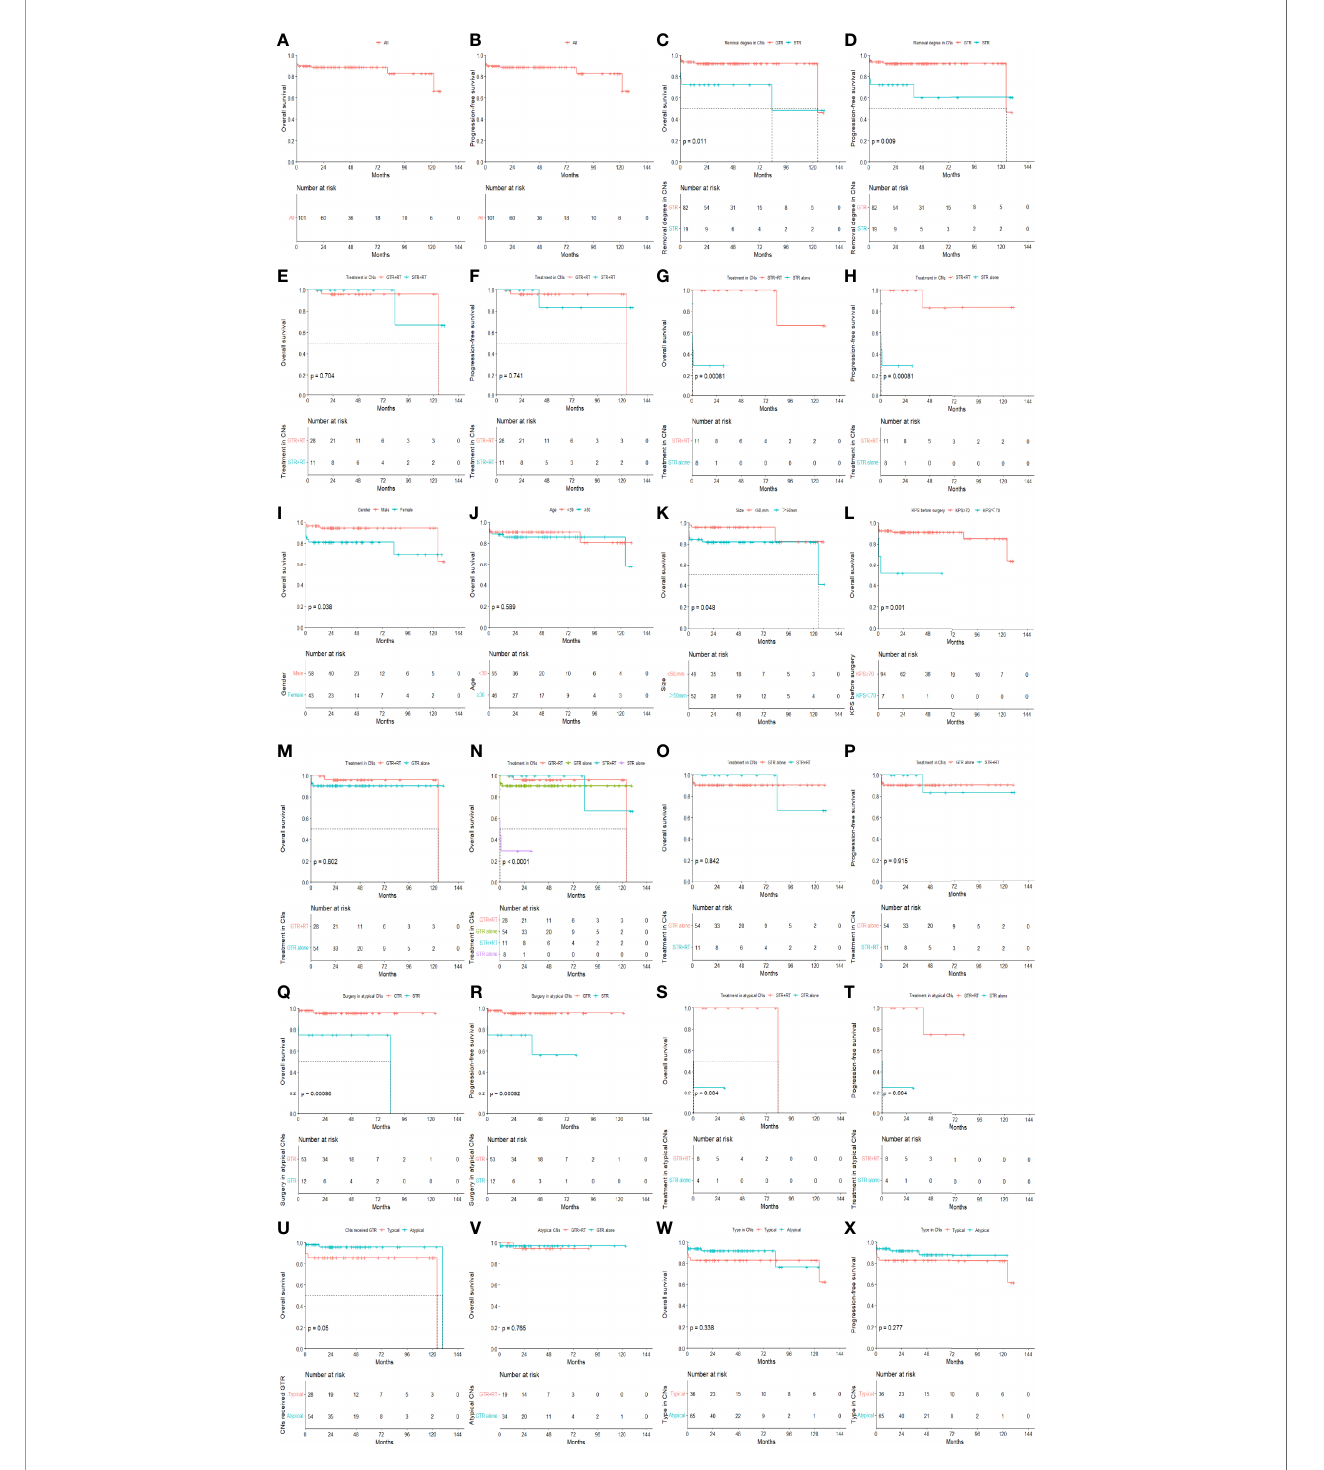
FIGURE 2 | The OS and PFS in all patients (A, B) . The effects of removal degree on OS and PFS in all patients (C, D) . The effects of removal degree on OS and PFS in all patients treated by RT (E, F) . The effects of radiotherapy on OS and PFS in patients treated by STR (G, H) . OS curves for patients with different